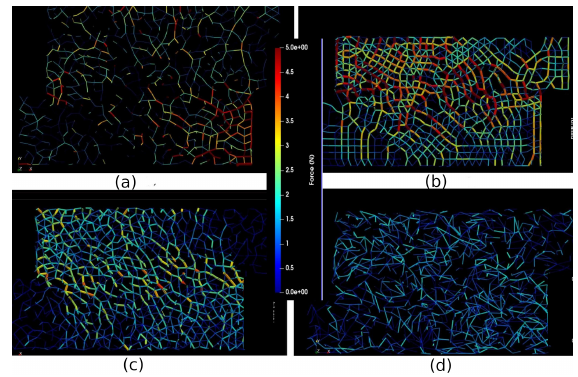
Figure 8. Force chain network of the final states ( P conf 50 kPa) (a) sphere, (b) cube, (c) Snome and (d) CrossP